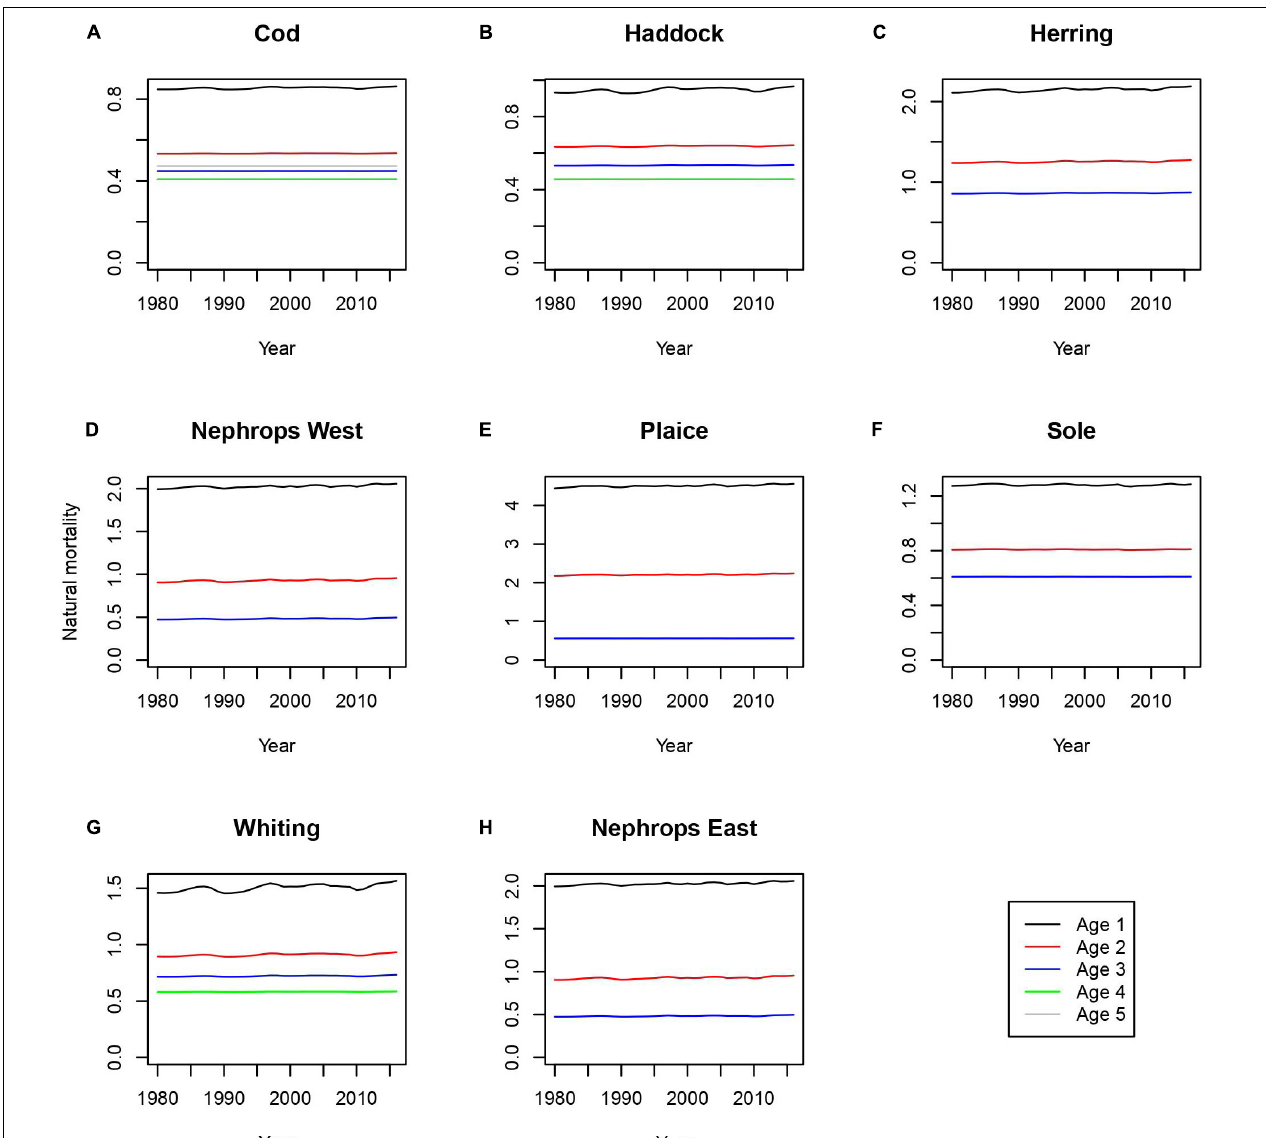
FIGURE 4 | Natural mortality through time for panels (A) cod, (B) haddock, (C) herring, (D) nephrops east, (E) plaice, (F) sole, (G) whiting, and (H) nephrops west. Black = age 1, red = age 2, blue = age 3, green = age 4, gray = age